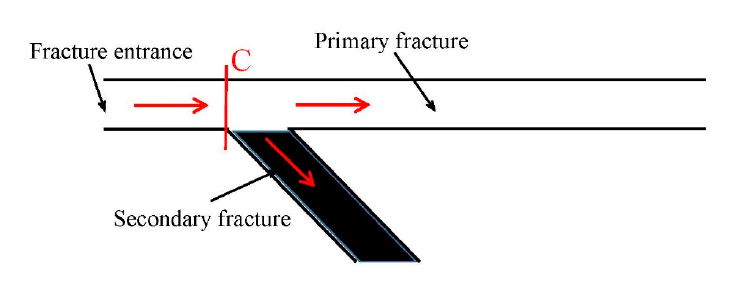
Figure 6. A top view of the cross fractures. The shaded part is the secondary fracture. Figure 7 gives the change of RPM with the dimensionless parameters mentioned in Equation (7). In order to reflect the distribution of the proppants in the primary fracture and the secondary fracture, the RPM is calculated with the same injected mass of the proppant. The RPM curve with the different inlet proppant volume fraction ( 𝛼 (cid:2929)(cid:2868) ) is shown in Figure 7a. When the inlet volume fraction of the proppant increases, the RPM decreases slightly from 6% to 3%. That means that the increase of the inlet volume fraction does not lead to the increase of the amount of the proppants entering the secondary fracture. More proppants stay in the primary fracture at the large inlet proppant volume fraction. The reason may be that the total resistance of the proppants on the water is larger at the larger inlet proppant volume fraction. The water velocity at the inlet of the secondary fracture is reduced accordingly. As a result, the amount of proppant entering the secondary fracture reduced.